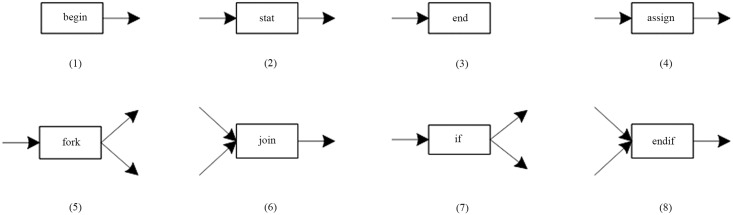
Components in Fig 8.